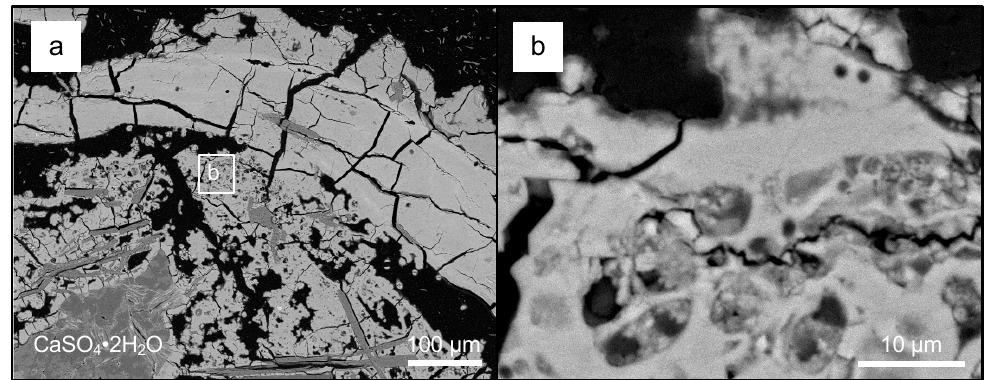
Figure 9. A low-magnification BSE SEM micrograph of schwertmannite/goethite surrounding larger gypsum crystals from the upper region ( a ). A low-magnification BSE SEM micrograph of oval, circular, and filamentous microfossils of various sizes observed within the schwertmannite/goethite coatings. Collectively, these structures are interpreted to be a mineralized biofilm ( b ).